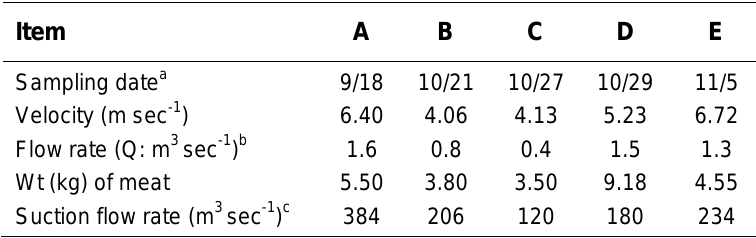
Sampling Conditions of Three PM Fractions in Each